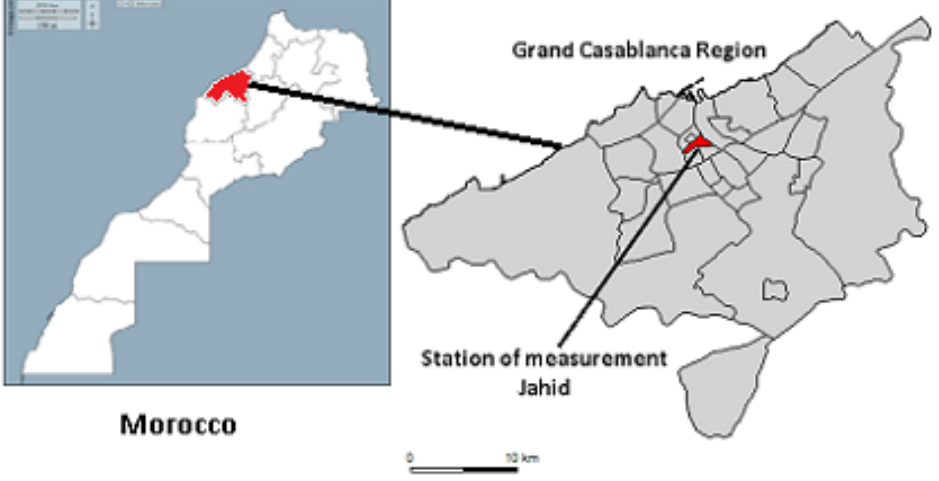
Figure 1. Map of GCR. The measurement station is a urban station (Jahid) located in the center of Casablanca. Source: Global Administrative Areas